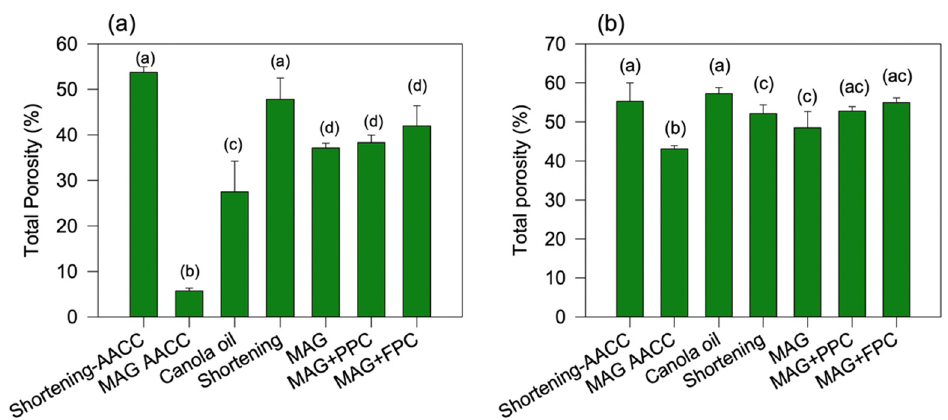
Figure 5. X-ray microtomography images of different cake batters. The names of the batters are shown on the top of each image. Shortening AACC and MAG oleofoam AACC batters were pre- pared using the AACC method, and the rest of the batters were prepared using the new lab-devel- oped method. MAG, monoacylglycerols; PPC, pea protein concentrate-stabilized foam; FPC, faba bean protein concentrate-stabilized foam.